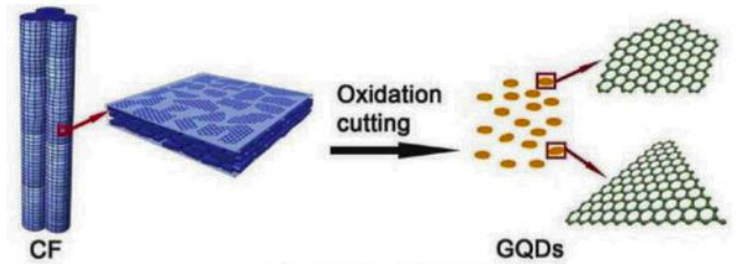
Figure 8. Schematic representation for the synthesis of GQDs by oxidative cutting, a top-down approach. Reprinted with permission from Ref. [18], Copyright (2012) American Chemical Society.